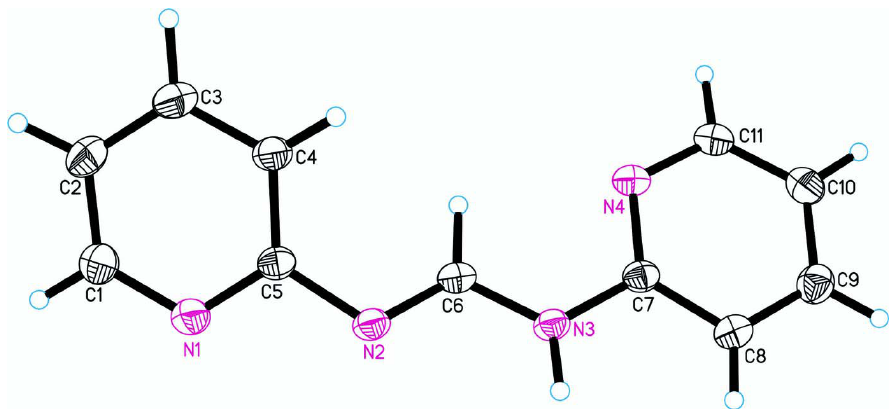
Figure 1 An ORTEP diagram showing the structure of the title compound with labeling and displacement ellipsoids drawn at the 30 % probability level.